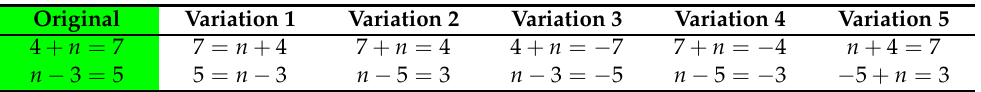
Table 14. Examples of type 1 and type 2 equation variations with n as the unknown.